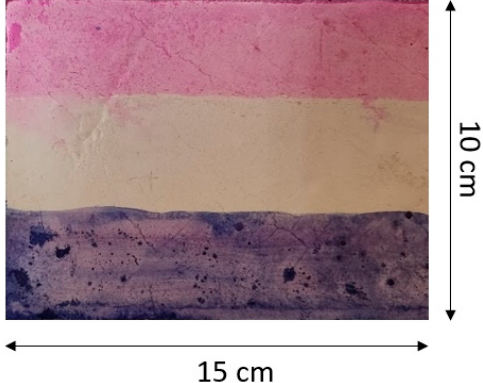
Figure 3. Tiles stained by rhodamine B and methylene blue.